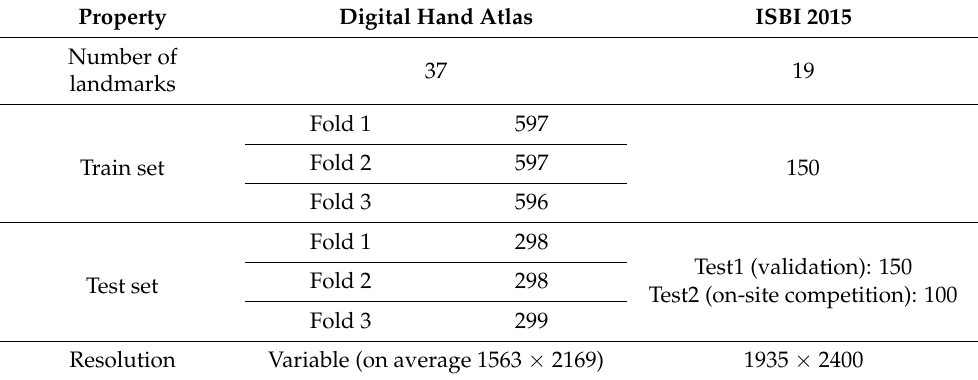
Table 1. Statistics of datasets.